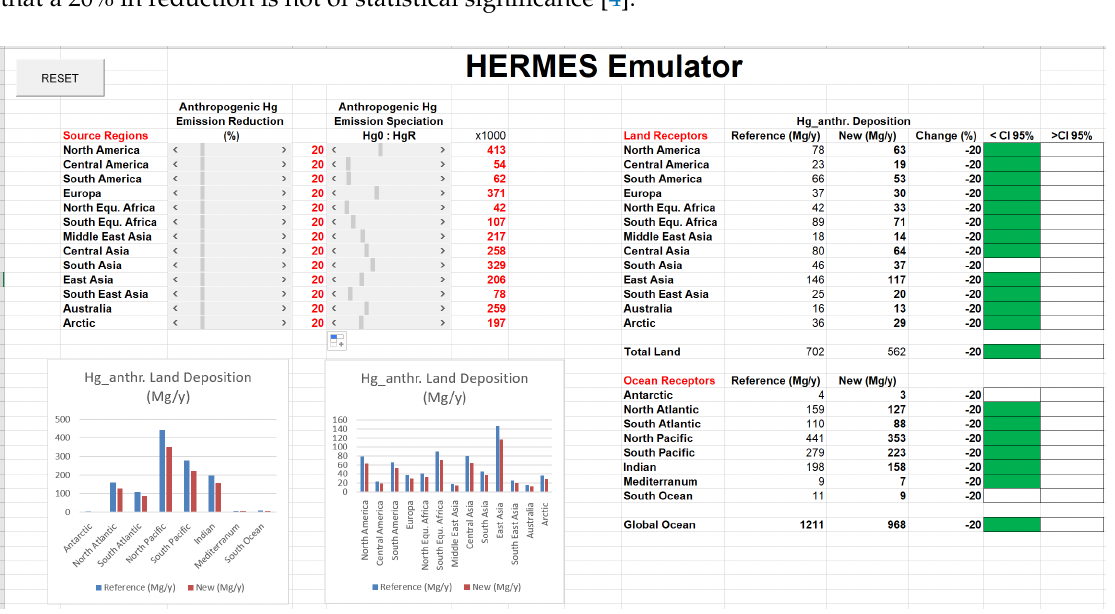
Figure 3. Use-case 1: Hg emission reduction by 20% from all source anthr